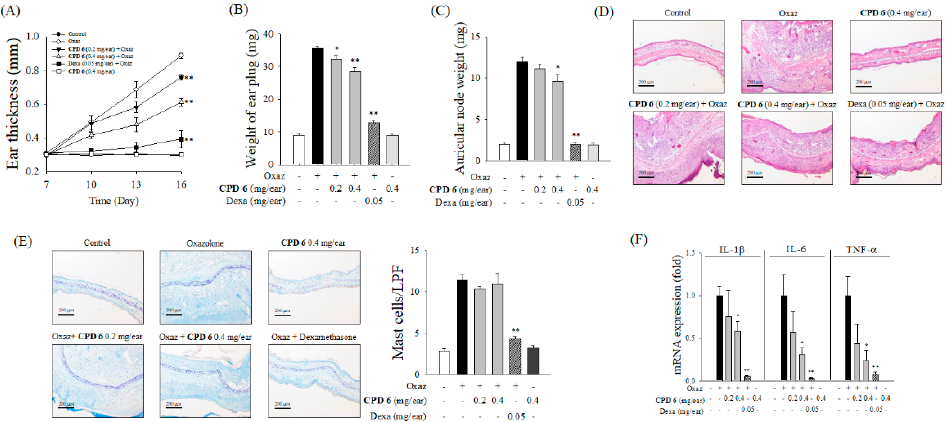
Figure 5. Anti-inflammatory effect of CPD 6 in oxazolone (Oxaz)-induced chronic dermatitis mouse model. On day 0, sensitization was initiated by topical oxazolone treatment on dorsal skin of BALB/c mice, and then inflammatory reaction was induced by challenge with topical oxazolone application on the right ear on days 7, 10, 13, and 16. Thirty minute before and 3 h after each elicitation, CPD 6 (0.2 or 0.4 mg) or dexamethasone (Dexa, 0.05 mg) was applied to the right ear. ( A to C ) The changes in ear thickness ( A ), the weight of ear plug ( B ), or auricular lymph node ( C ) were examined at 6 h after the final oxazolone challenge. ( D ) Representative images of H&E staining of right ear tissues from each group are shown (upper panel) with histological scores (lower panel). Scores of ear edema, epithermal hyperproliferation, and leukocyte infiltration were expressed as black, white, and gray bars, respectively. ( E ) Representative histological images of right ear tissue in TB-staining were shown (left panel) and the mast cell counts were plotted (right panel). ( F ) The mRNA levels of pro-inflammatory cytokines in right ear tissues were determined 6 h after the final oxazolone application. Data are expressed as mean ± SEM, * p < 0.05, ** p < 0.01 vs. oxazolone-treated group. N = 5. Table 2. Effect of CPD 6 on histological inflammatory observations in oxazolone-induced chronic dermatitis. Groups Histological Score (mean ± S.D.)